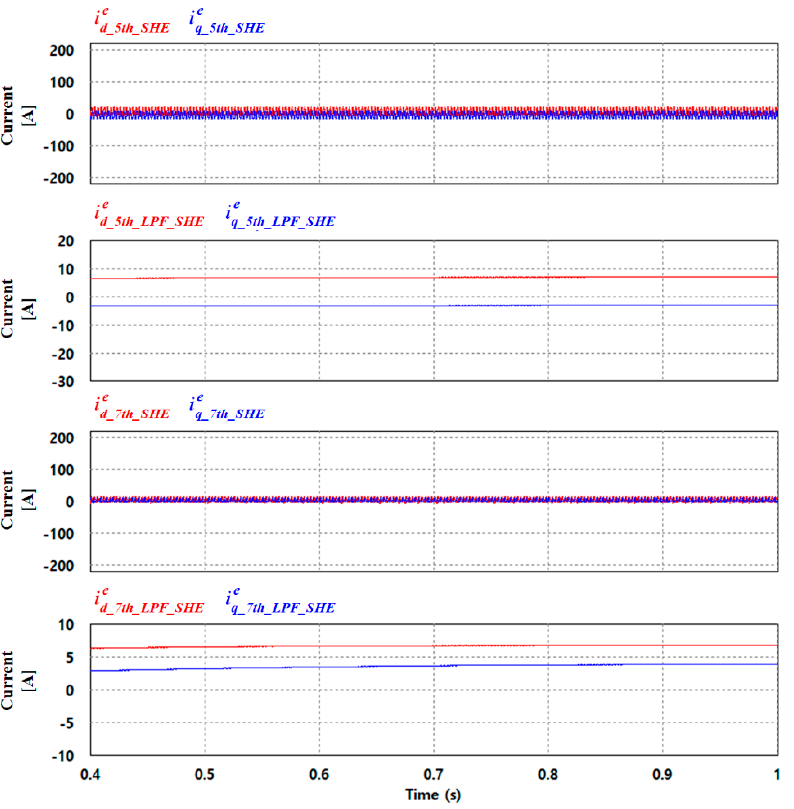
Figure 11. Harmonic currents extracted using the SHE method. Table 3. Harmonic signal ratio of each harmonic compensator.